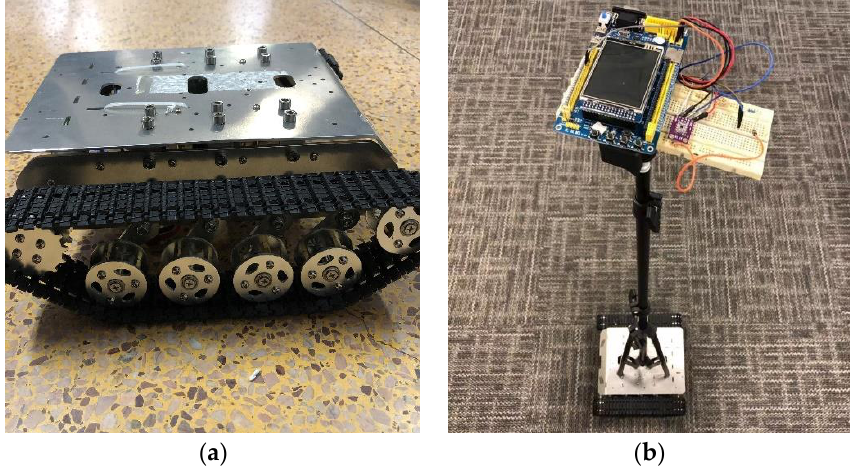
Figure. 2. Experiment Setup.